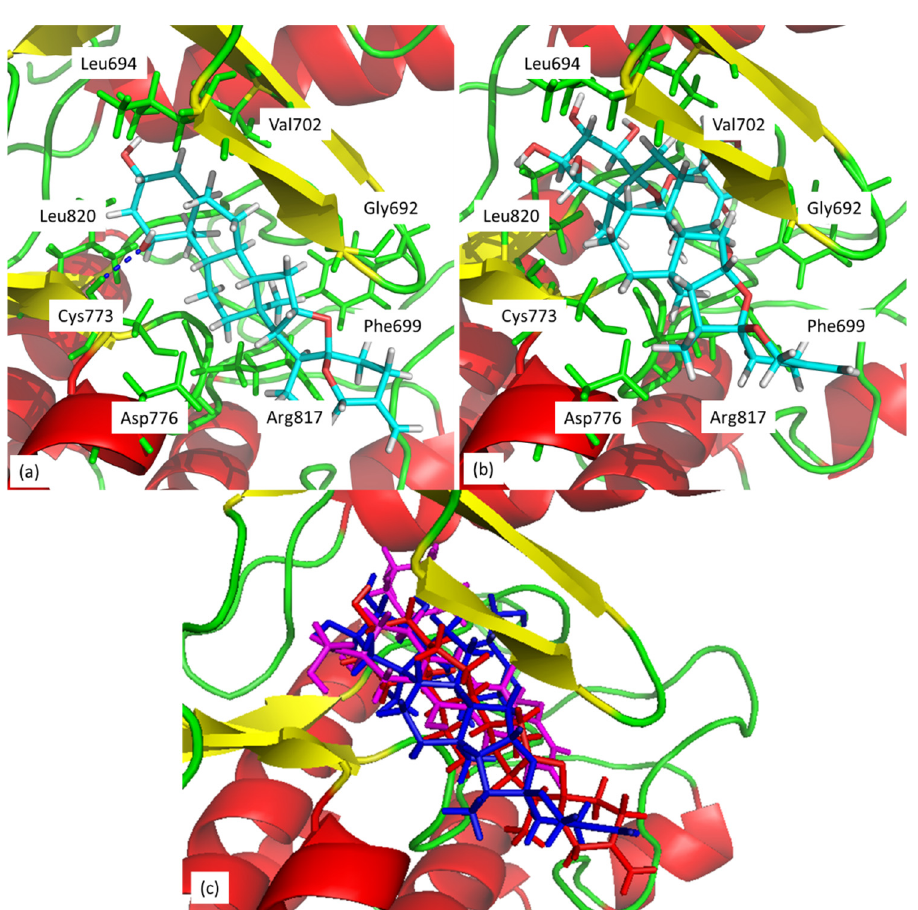
Figure 3. Docking and binding pattern of compounds ( a ) 1 , ( b ) 9 , ( c ) together 1 (red molecule), 9 (blue molecule), and doxycycline (magenta molecule), in the active site of the HER2